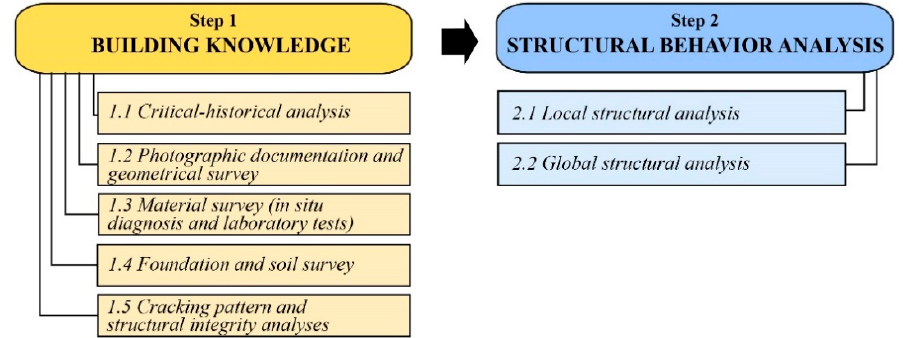
Figure 1. General scheme of the procedure necessary for a complete structural behavior analysis of a historical structure.